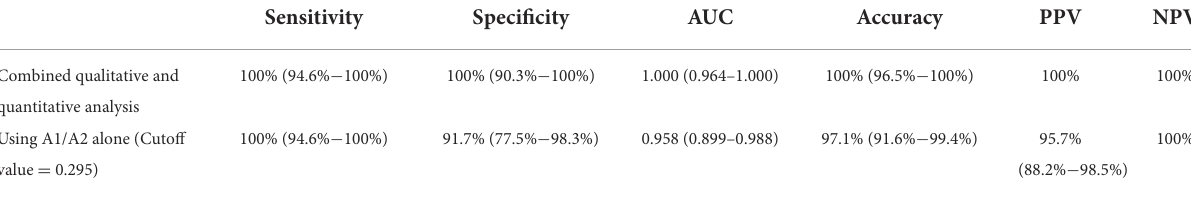
TABLE 3 Comparison of diagnostic performance in differentiating thrombus from cardiac